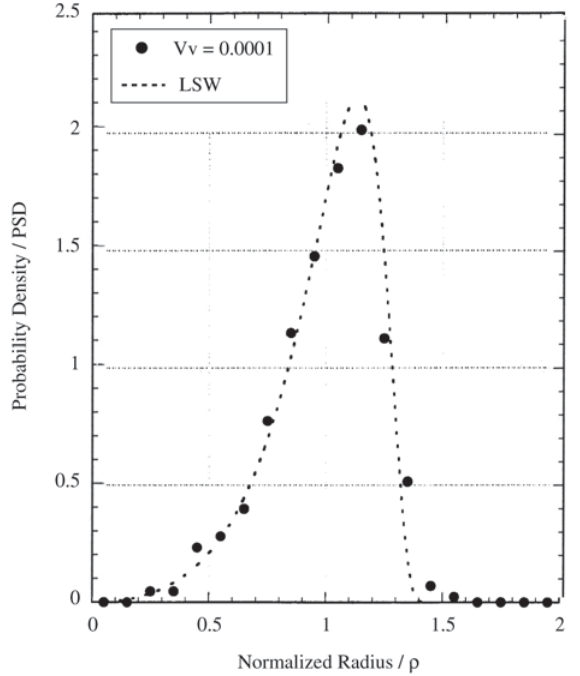
Figure 4. Particle size distribution (PSD). Plot of the probability density, G( ρ ), of finding particles of radius ñ in a small range of sizes, d ρ , versus normalized particle radius. Data are for a small but non-zero volume fraction (V =10 -4 ). At finite, non-zero values V of V , the PSD broadens toward larger radii , drops in height, and V becomes slightly more symmetrical than predicted from LSW theory. Multiparticle interactions are responsible for these changes.